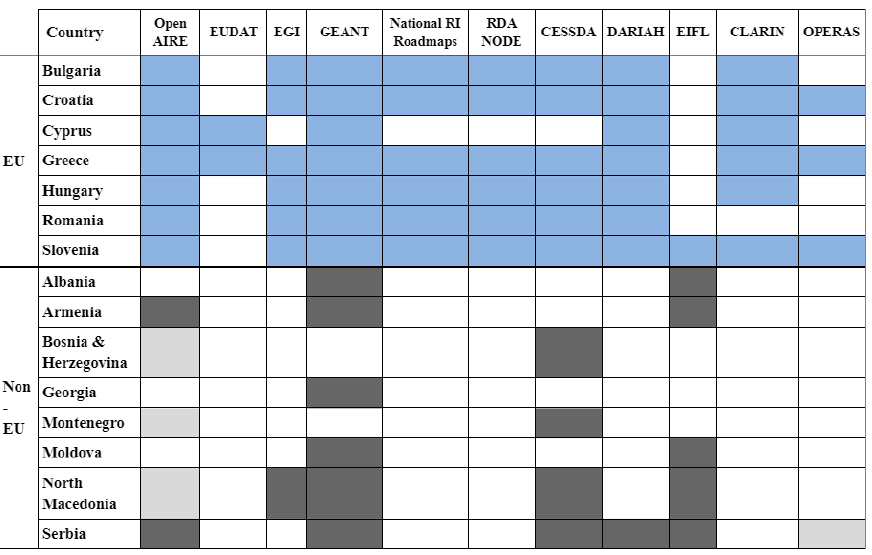
Figure 1. Participation of the NI4OS-Europe partner countries in European Open Science networks.